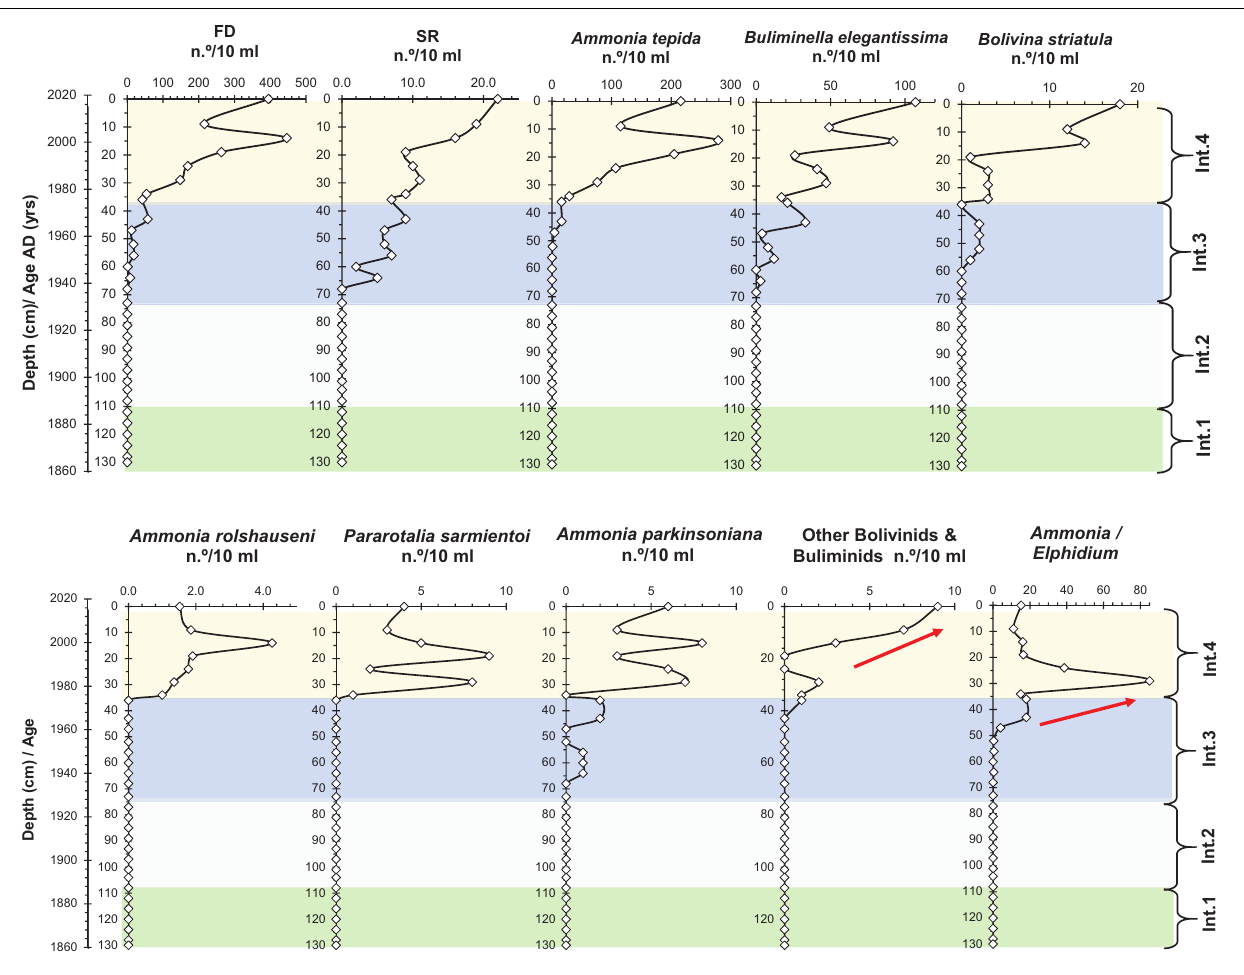
exhibits a negative correlation with Al ( Table 3 ). Bolivina striatula and C. excavatum are correlated with the period around 2004. Foraminiferal species do not have a significant correlation with the negative axis of PC2. The CCA results for axes one and two (explaining 56.5 and 11.3%, respectively, of data variability) represent the